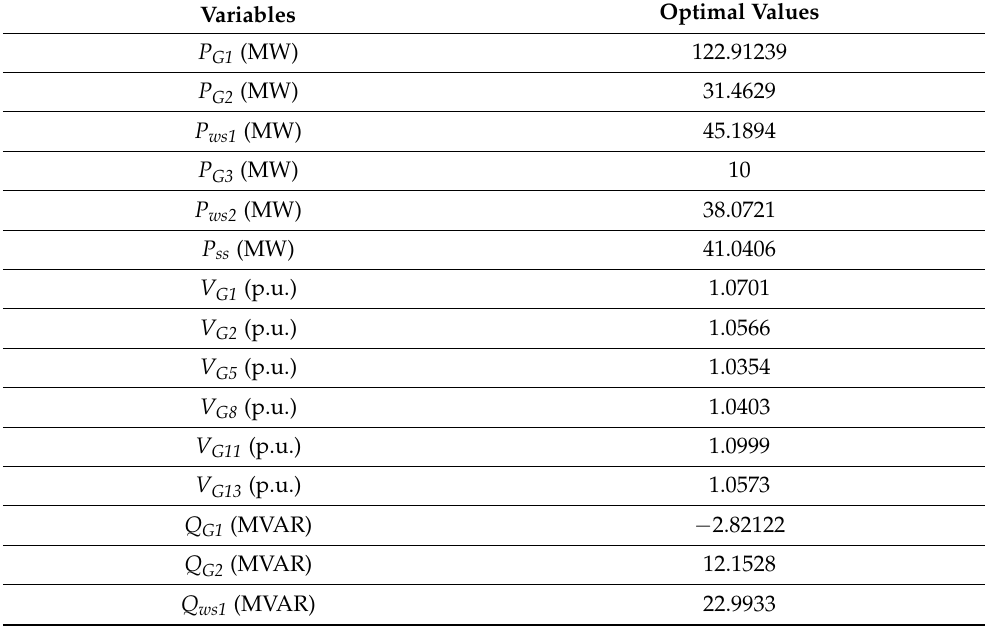
Table 11. The optimal values by HFAJAYA for Case